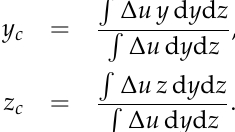
Figure 14. Variation of ( a ) < M θ > ∗ = < M θ > / ρ d ¯ u 2 (cid:113) > / ρ d ¯ u 2 M (cid:48) 2 with y c for different values of x c h θ